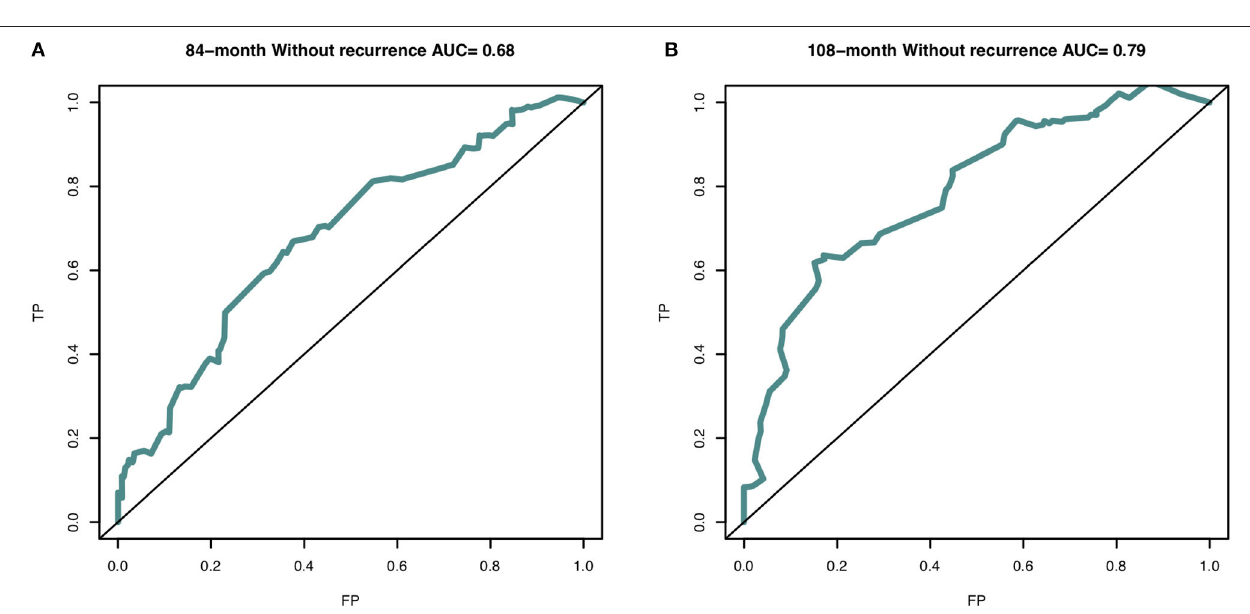
FIGURE 3 | The area under curve (AUC) of nomogram predictive model at (A) 84-month (AUC = 0.716) and (B) 108-month (AUC = 0.796) in the derivation cohort. The receiver operating characteristic curve (ROC) is made via R package “survivalROC”. TP, true positive-rate; FP, false